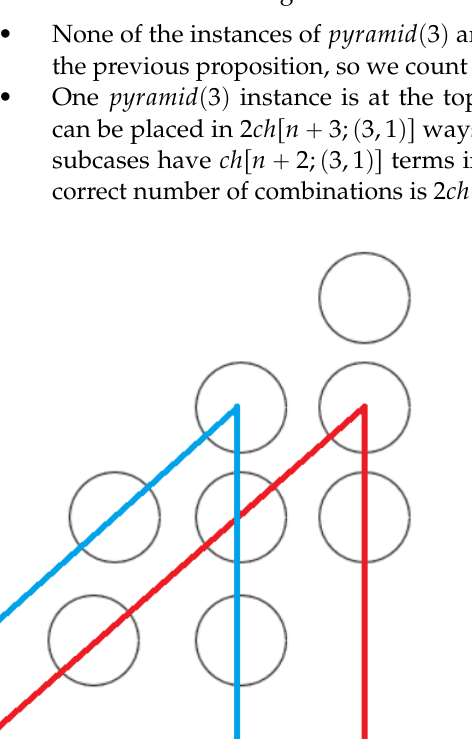
Figure 16. Stacking any pyramid onto pyramid(3) in the vertex, where the red and blue lines collide and continue the process of stacking pyramids iteratively. This process describes a family of pyramids counted twice: once under the blue region and once under the red